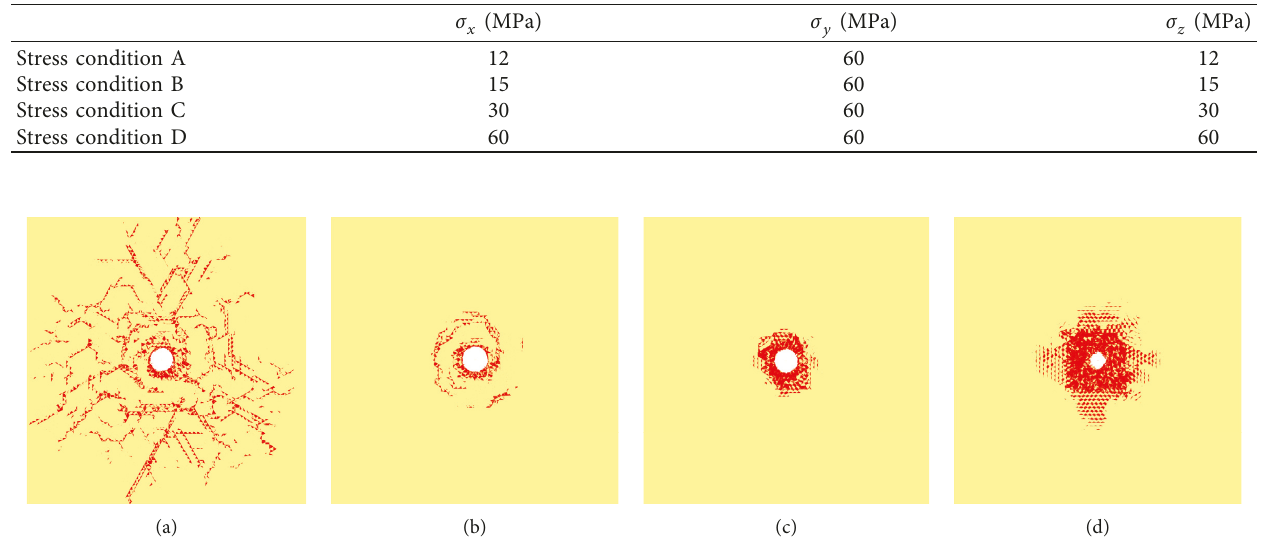
Figure 12: Fracture distribution around the roadway boundary under different confining pressure: (a) stress condition A, (b) stress condition B, (c) stress condition C, and (d) stress condition D.